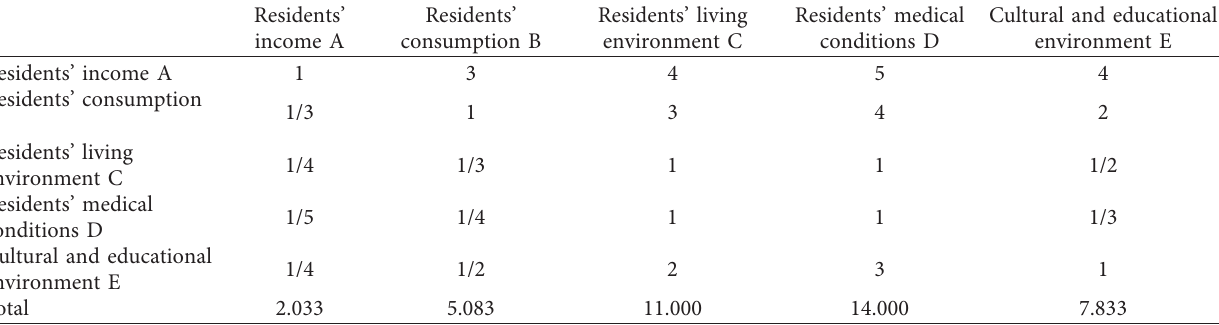
Table 4: Summary of the pairwise judgment matrix.